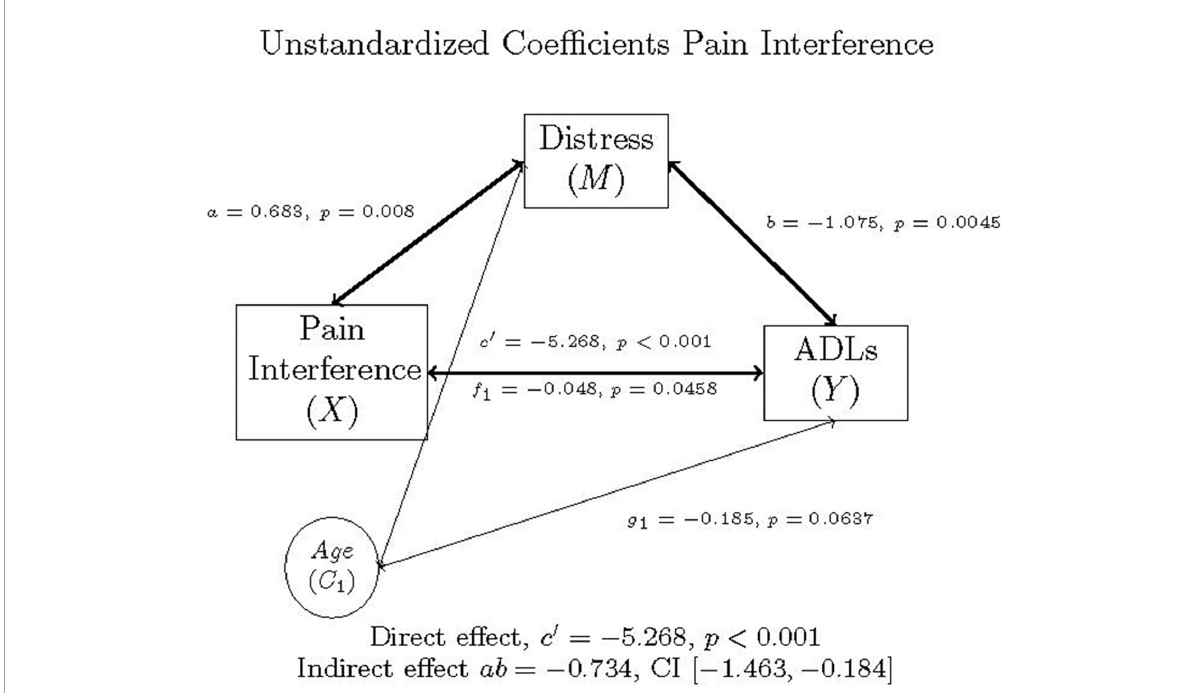
FIGURE2 Mediation model of pain interference, distress, ADLs, and age in individuals with FM, as well as the direct effect, indirect effect, and confidence interval using unstandardized (b)